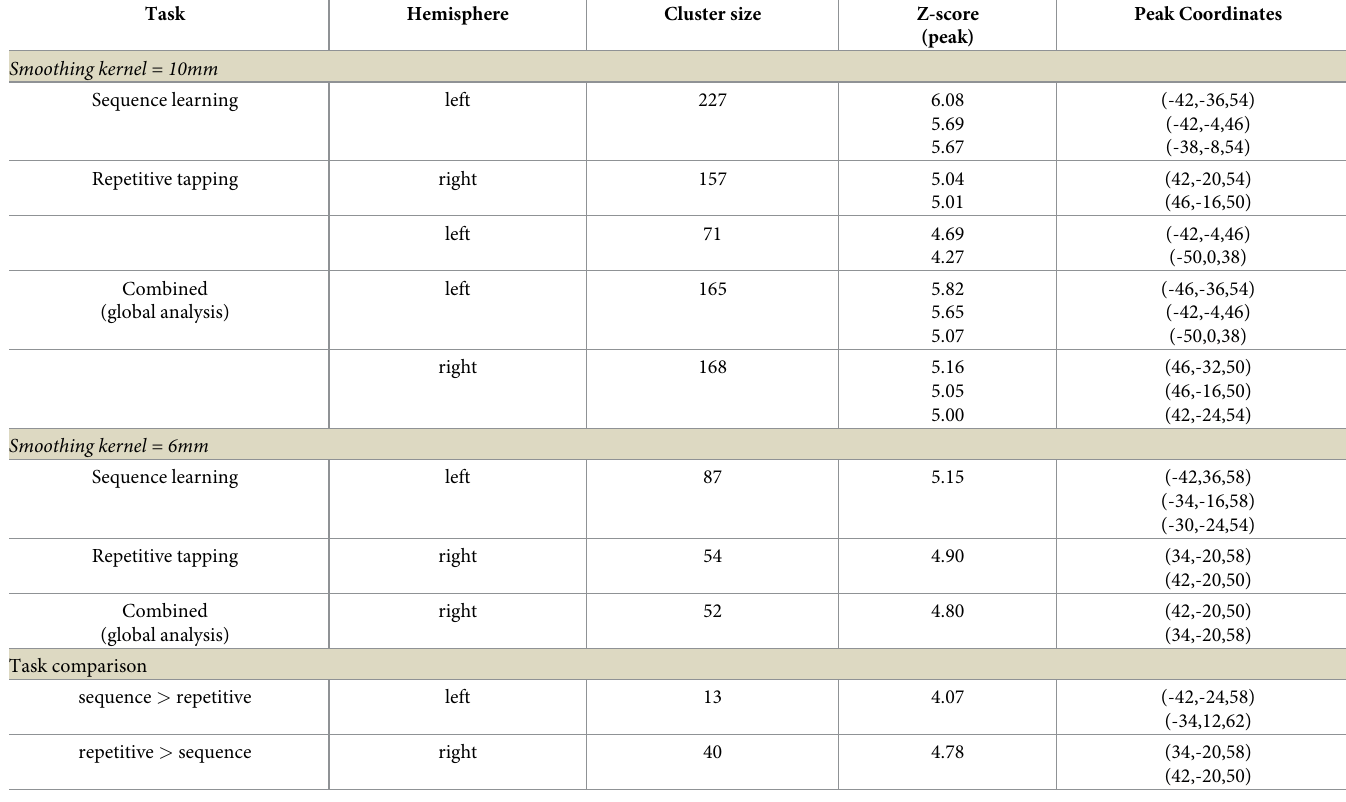
Table 3. Location of group sensorimotor cortical